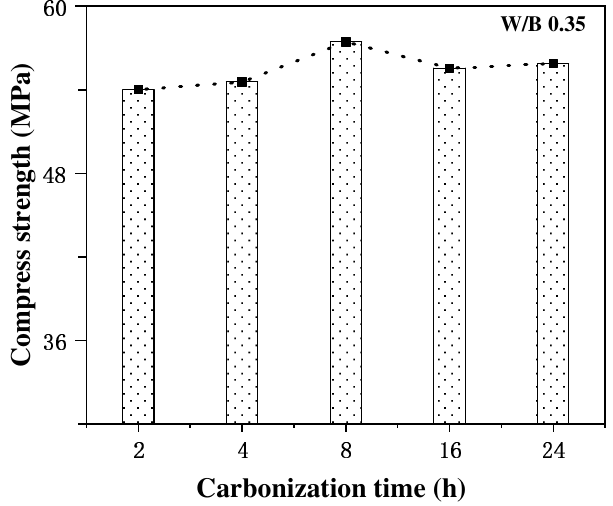
Figure 3. Variation in compressive strength with carbonation curing time